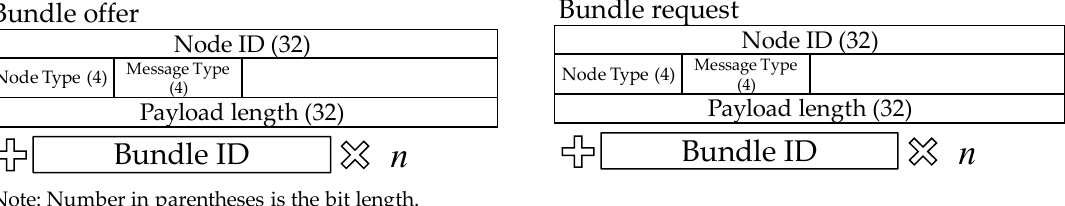
Figure 16. Structures of messages exchanged between a relay node and a receiving node.